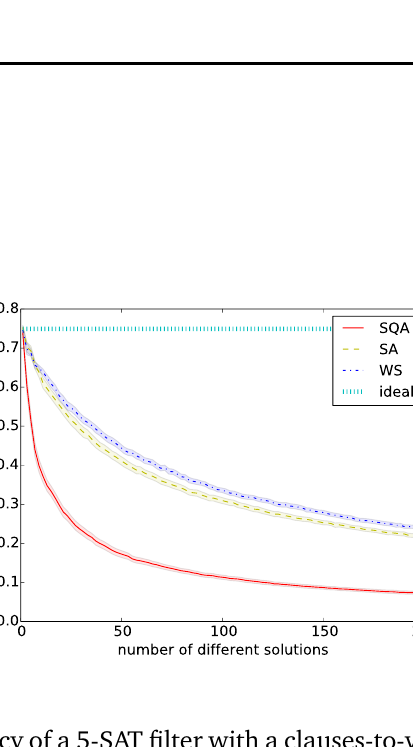
Figure 12: Average efficiency of a 5-SAT filter with a clauses-to-variables-ratio of α χ The solutions used to construct the filter were chosen randomly from the found solutions.